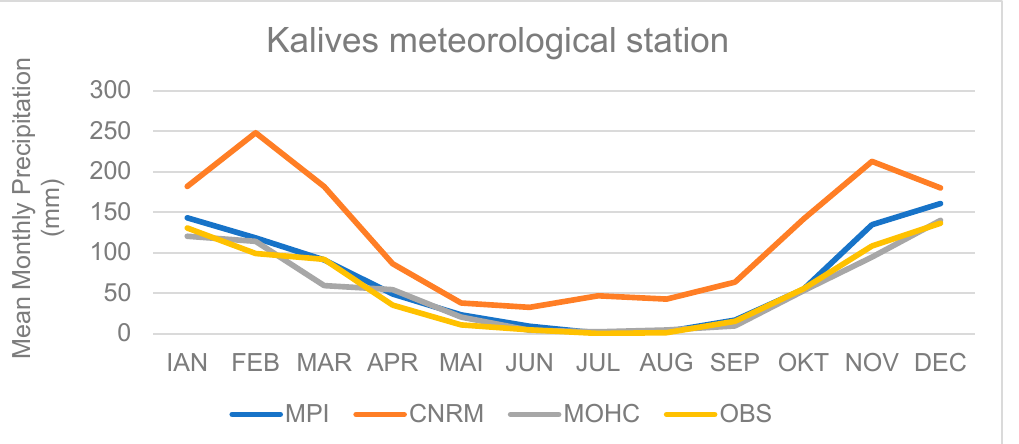
Figure 9. Mean monthly precipitation observations (OBS) and precipitation simulations by RCMs (MPI, CNRM, and MOHC) at Kalives .